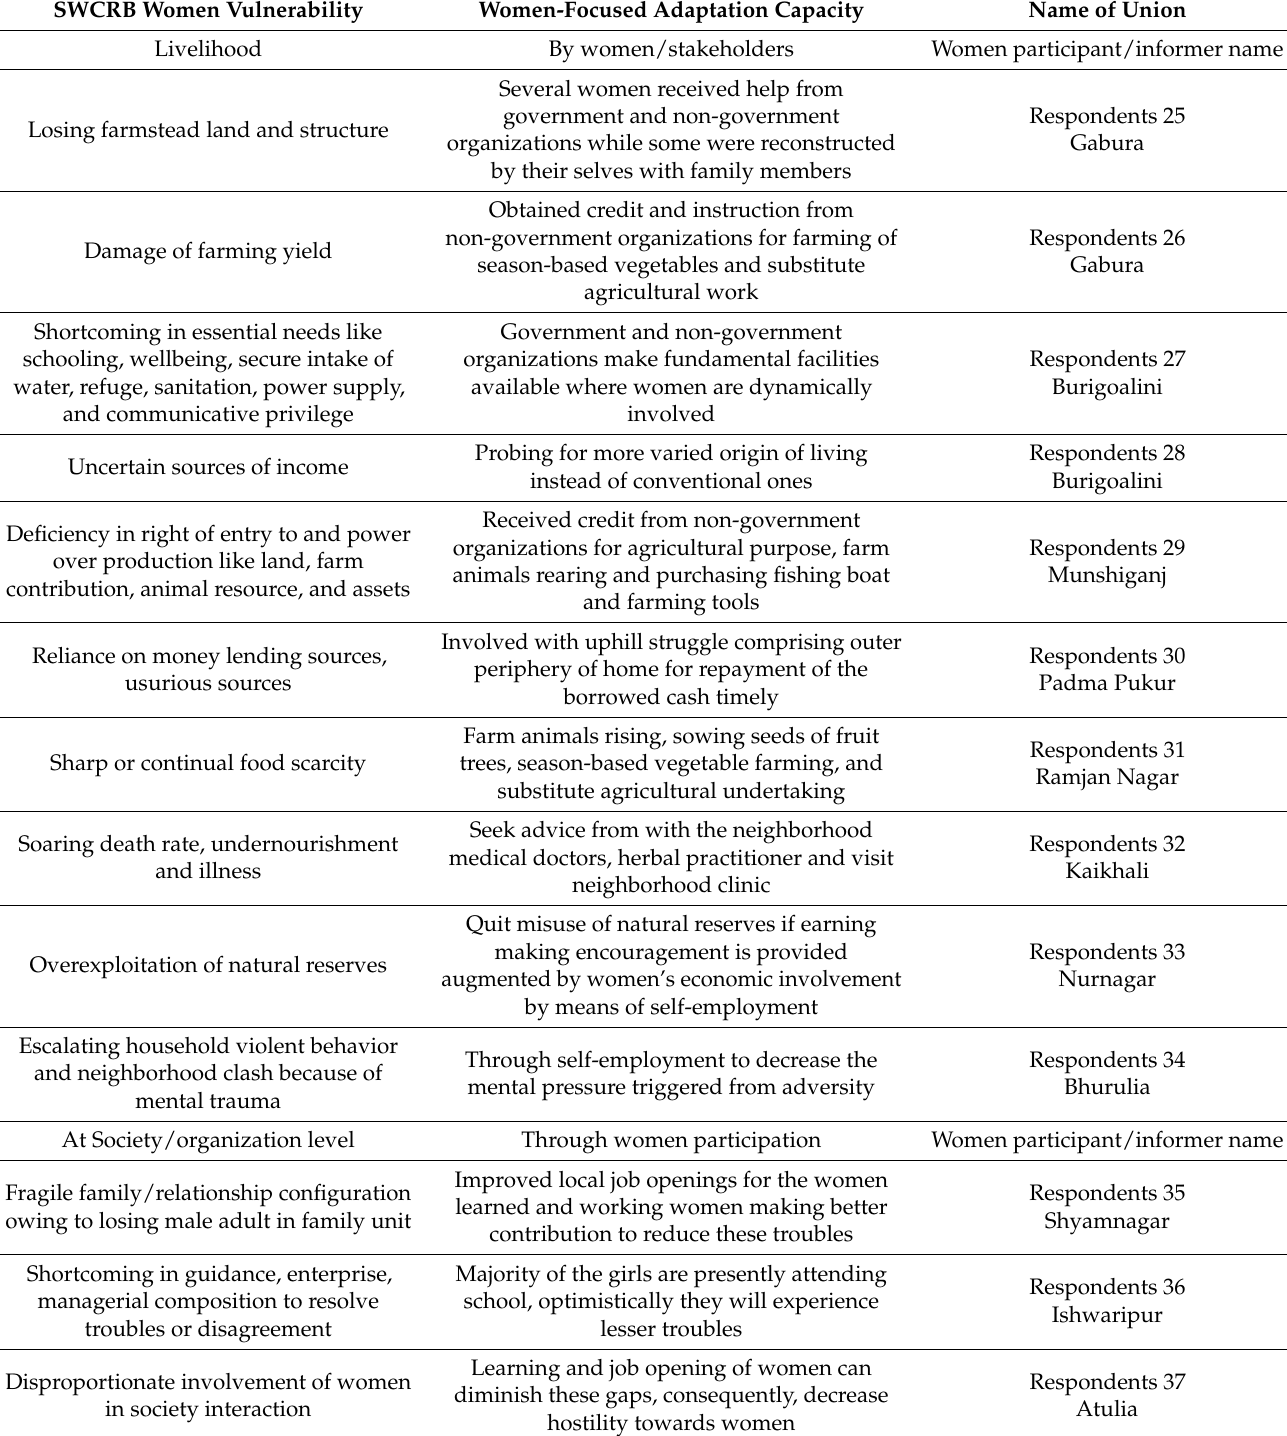
Table 8. Women’s vulnerability and recovery capacities in the